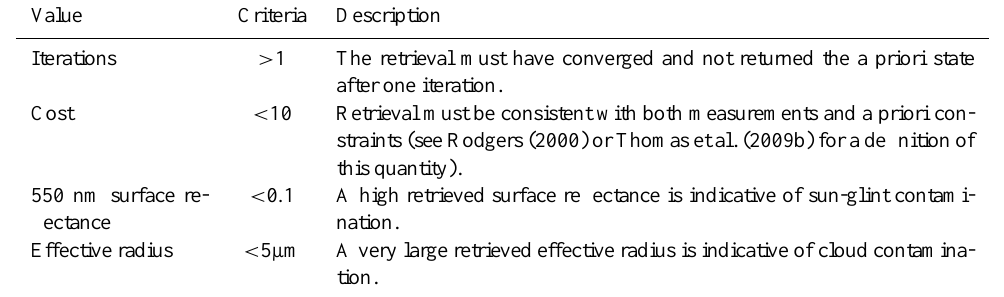
Table 2. Quality control applied to GRAPE level 2 aerosol data. Only retrievals which satisfy all of these tests are used in this analysis. Value Criteria Description Iterations > 1 The retrieval must have converged and not returned the a priori state after one iteration. Cost < 10 Retrieval must be consistent with both measurements and a priori con- straints (see Rodgers (2000) or Thomas et al. (2009b) for a definition of this quantity). < 0 . 1 A high retrieved surface reflectance is indicative of sun-glint contami- 550 nm surface re- flectance nation. Effective radius < 5µm A very large retrieved effective radius is indicative of cloud contamina-